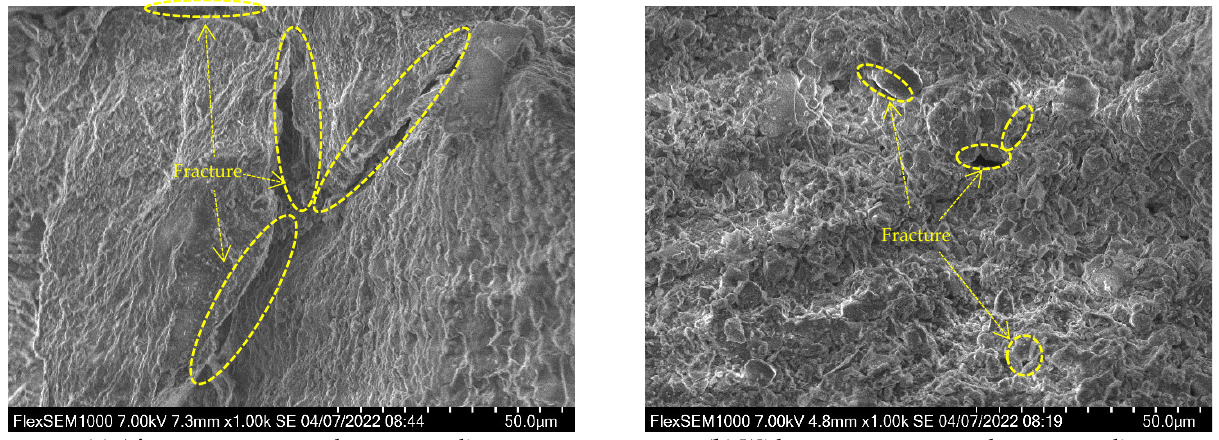
Figure 13. SEM test photos of sandstone specimens.